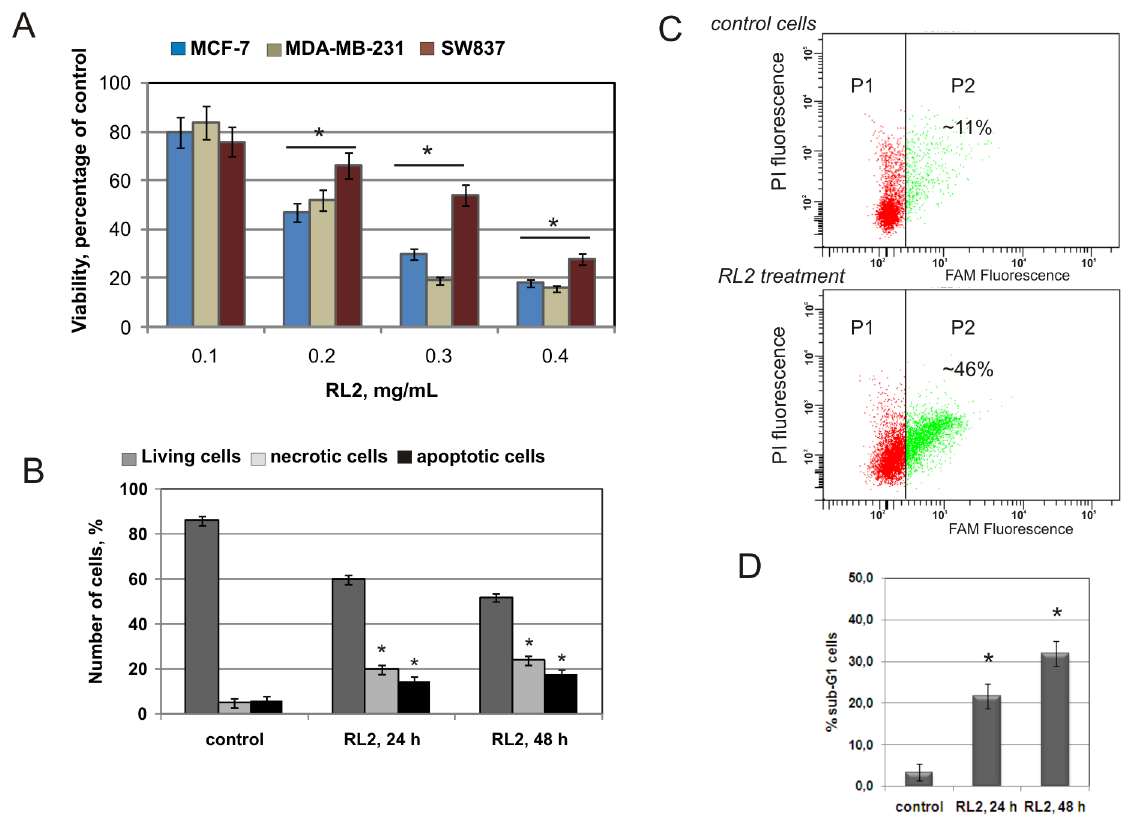
Figure 1. RL2 decreases viability and induces apoptosis in cultured cells. A . Cells were treated with different concentrations of RL2 or with saline (control) for 48 h and MTT analysis was performed. Data are presented as the mean of at least three separate experiments for each cell line. The error bars represent standard deviations ( 6 SD). The asterisks indicate significant difference from control (*, p , 0.05). B . MDA-MB-231 cells were incubated with RL2 (0.2 mg/mL) for 24 and 48 h then cells were stained using annexin V/propidium iodide (PI). The stained cells were assayed for apoptosis by flow cytometry. Cell populations with the annexin V 2 /PI 2 phenotype were designated as living cells, annexin V + /PI 2 - as apoptotic cells, and annexin V + /PI + - as necrotic cells. Data are presented as the mean of at least four separate experiments. *, p , 0.05 compared with corresponding controls. C . MDA-MB-231 cells were incubated with RL2 (0.2 mg/mL) for 24 h and the percentage of cells with active caspase 2 3, 2 7 were analysed using flow cytometry. FAM is fluorescein (ex 488 nm, em 530 nm). P2 population represents MDA-MB-231 cells positively stained with FAM-DEVD- FMK caspase-3 and 2 7 reagent. Shown are mean percentages of four independent experiments. D . DNA fragmentation in MDA-MB-231 cells was investigated after RL2 (0.15 mg/mL) treatment. Sub-G1 (late apoptotic) population was estimated by flow cytometry after propidium iodide staining. Data are presented as the mean of at least three separate experiments. *- significantly different from control, p , 0.05.